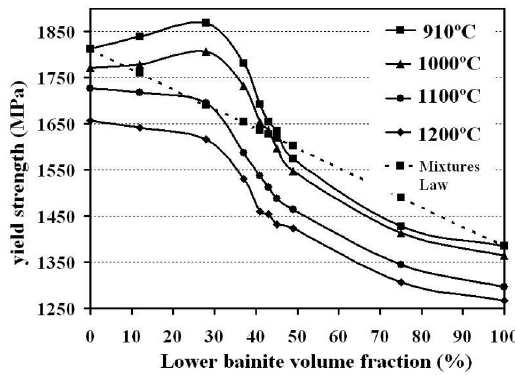
Figure 4. Variation of yield strength with amount of the lower bainite for various austenitizing temperatures.